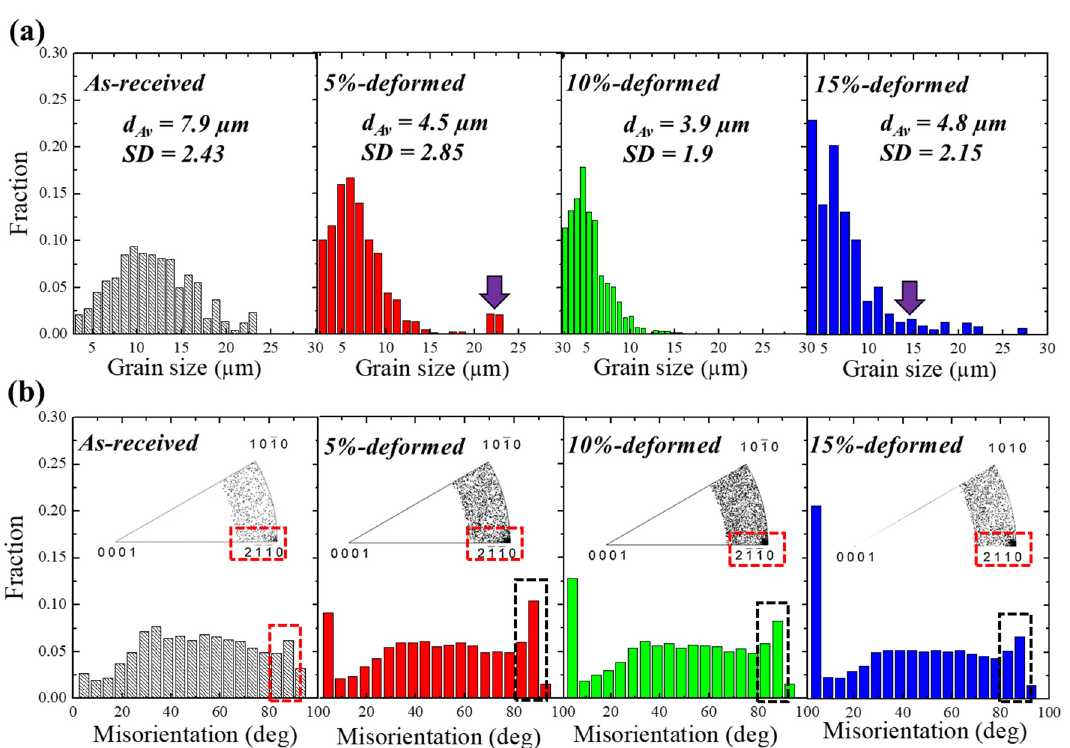
Figure 2. (a) Grain size distributions and ( b ) misorientation profiles of as-received and pre-stretched (5%, 10% and 15%) samples. The figure inserted in Figure 2b is the misorientation distribution function of the samples.